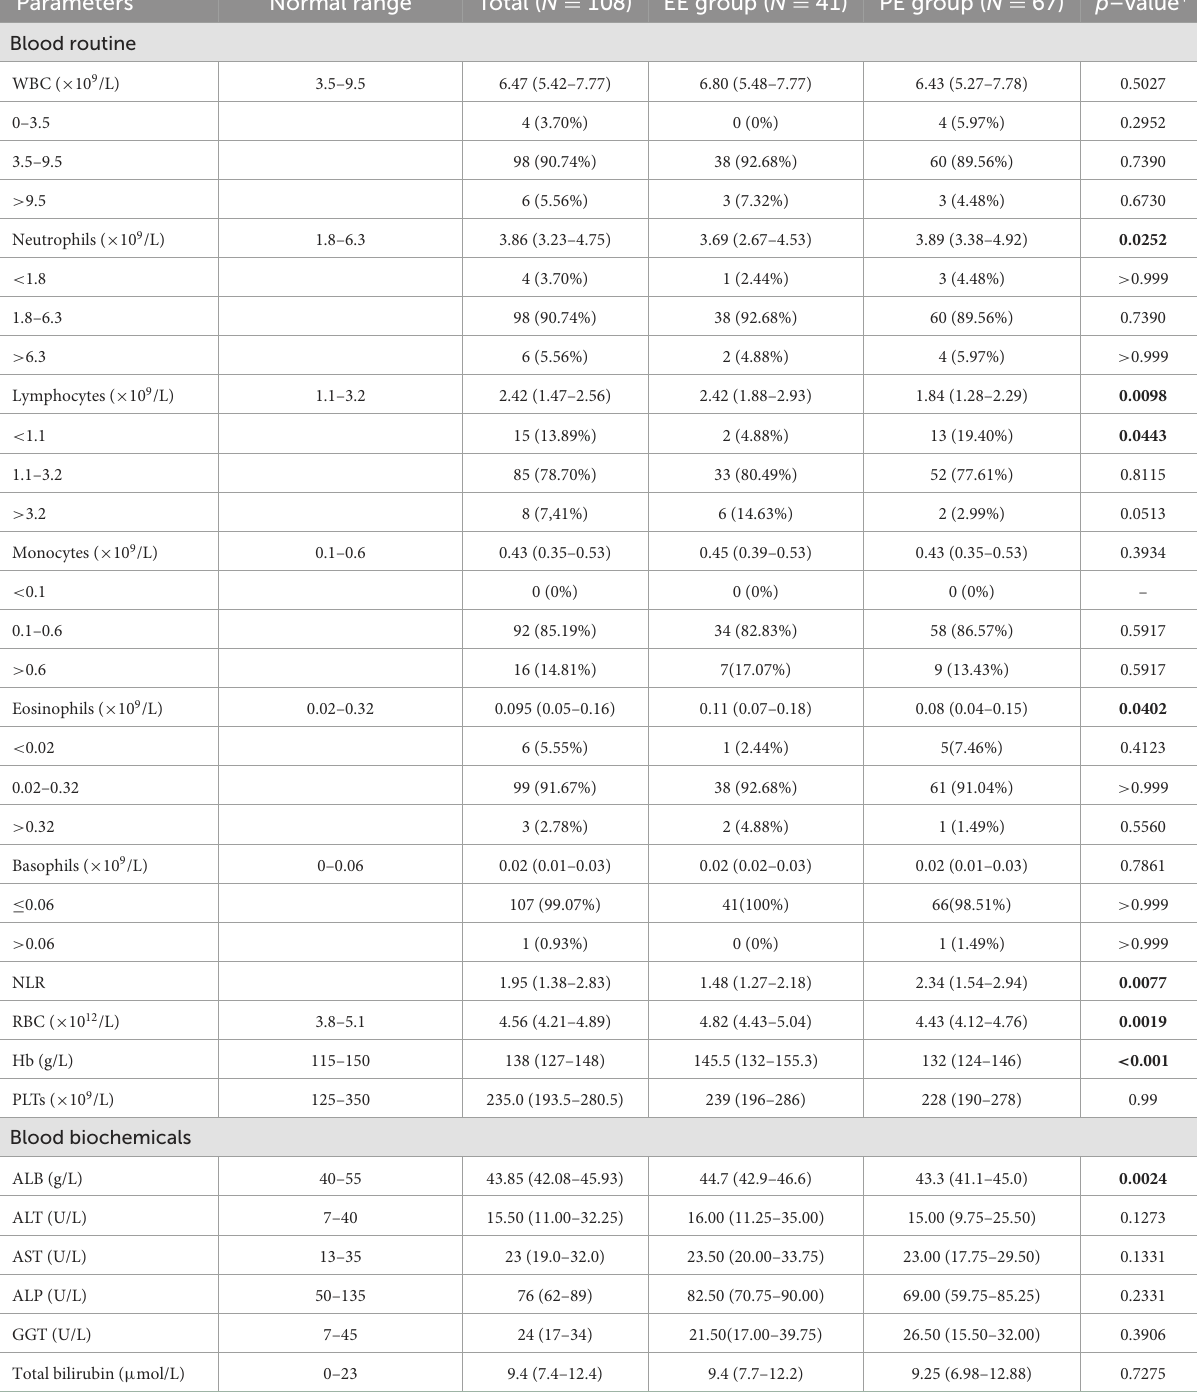
TABLE 3 Blood routine and blood biochemicals expression in COVID-19